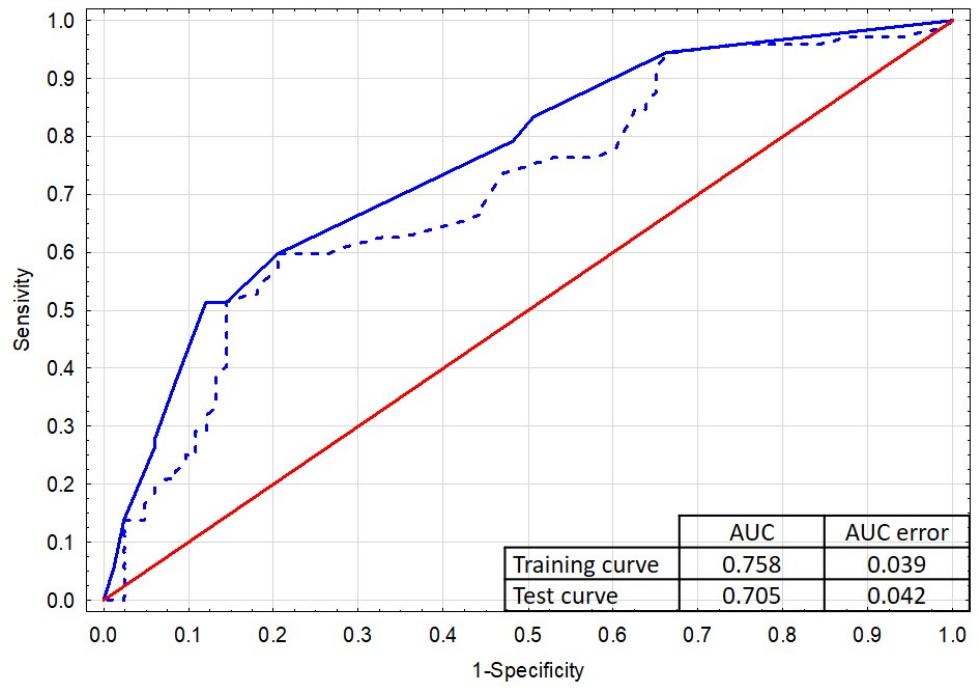
Figure 3. V-fold cross validation—learning ROC curves. Blue solid line—training curve, blue dashed Figure 3. V ‐ fold cross validation—learning ROC curves. line—test curve, red line—reference Blue solid line – training curve, blue dashed line – test curve, red line – reference line